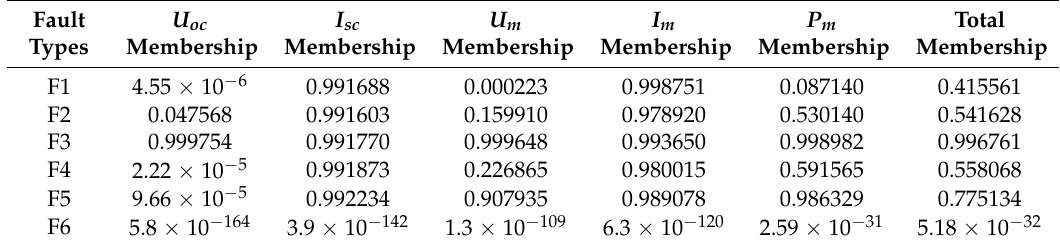
Table 5. Membership degree between fault sample and each cluster